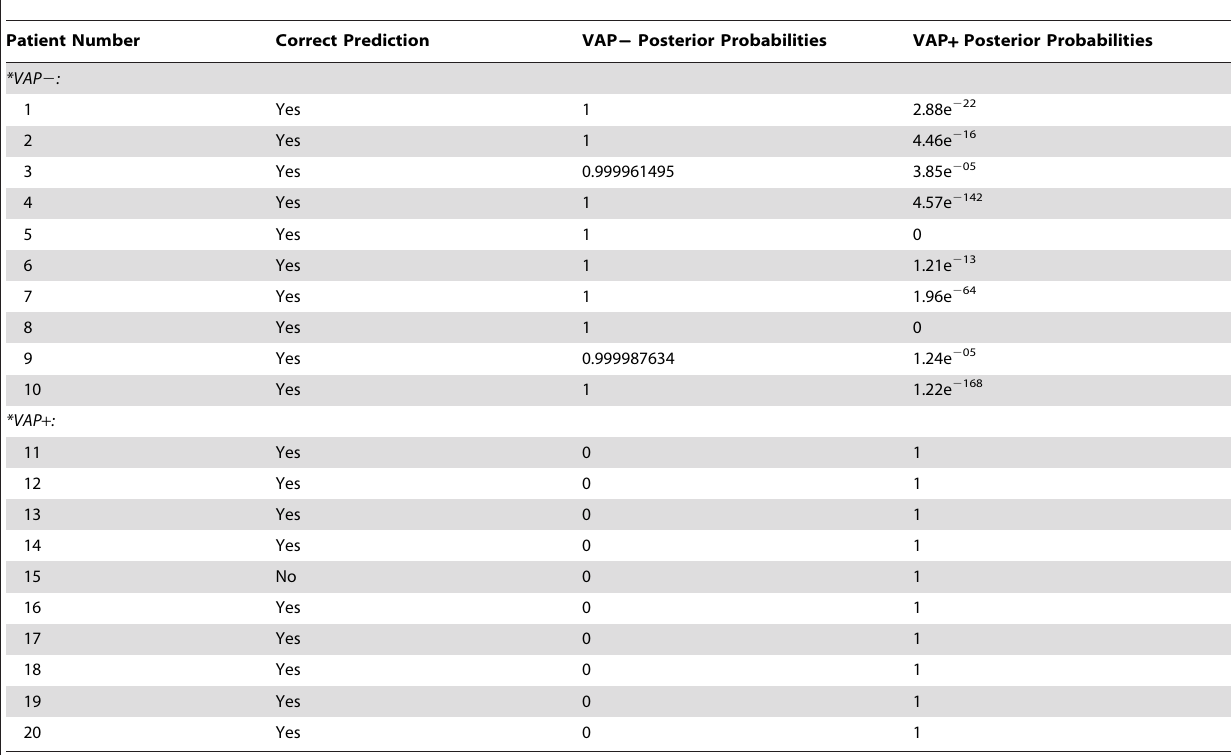
Table 2. Positive predictive value for ventilator-associated pneumonia using the expression profiles of the top five genes.